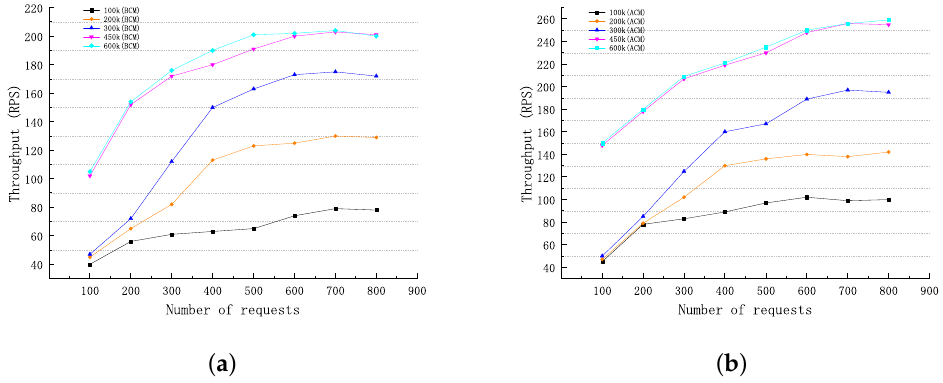
Figure 10. Create Request Test. ( a ) Before Configuration Modification. ( b ) After Configuration